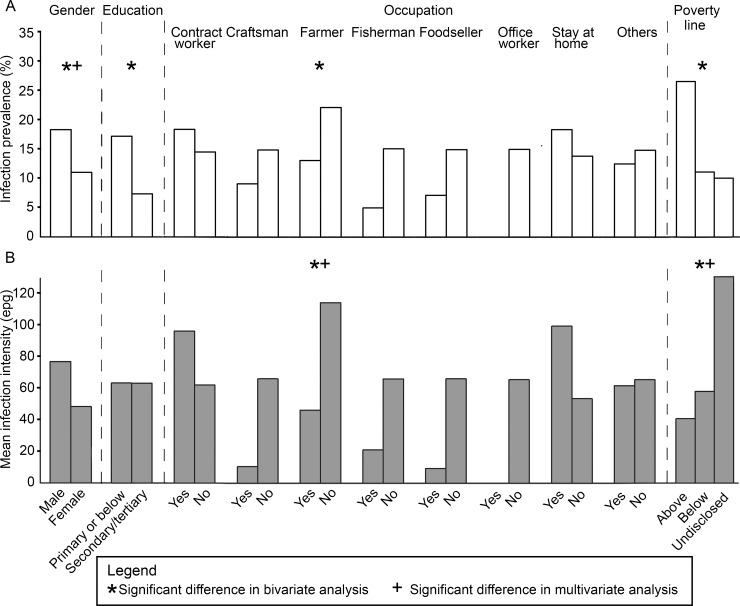
Socio-economic and demographic factors as risk factors for O. viverrini infection.(A) O. viverrini infection prevalence and (B) mean intensity of infected participants of various socio-economic and demographic factors.